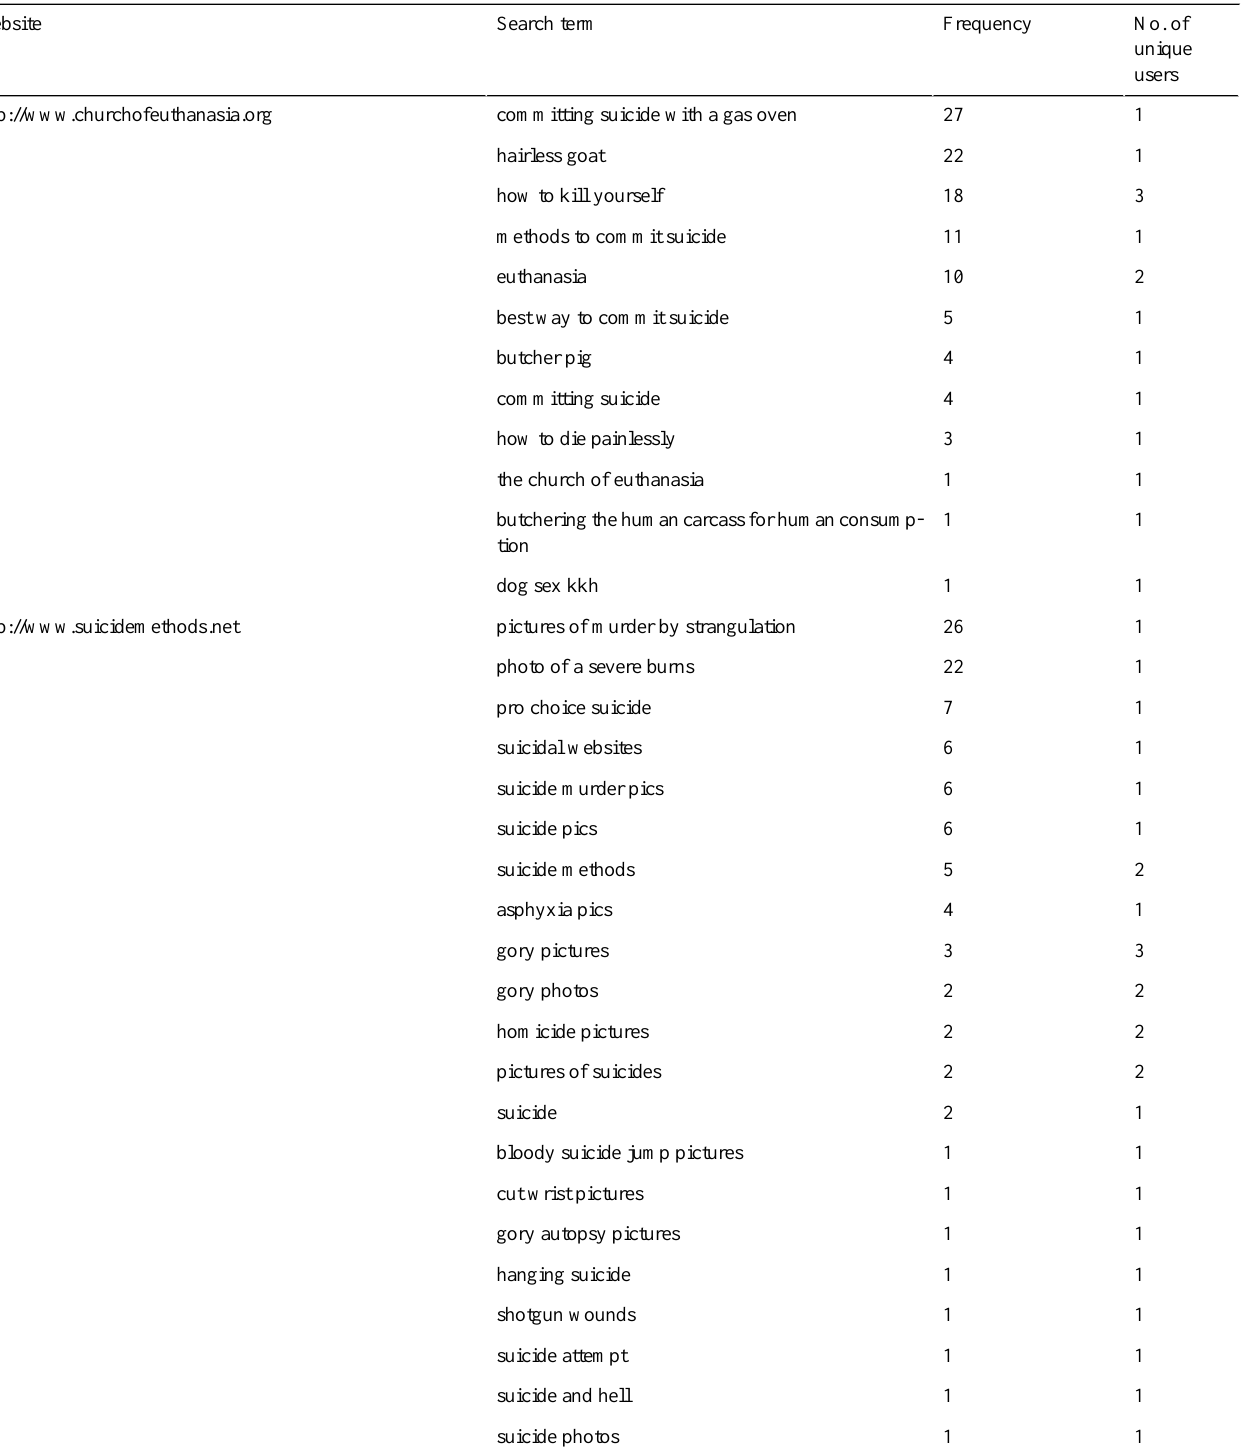
Table 3. Search terms used to access the two pro-suicide websites.